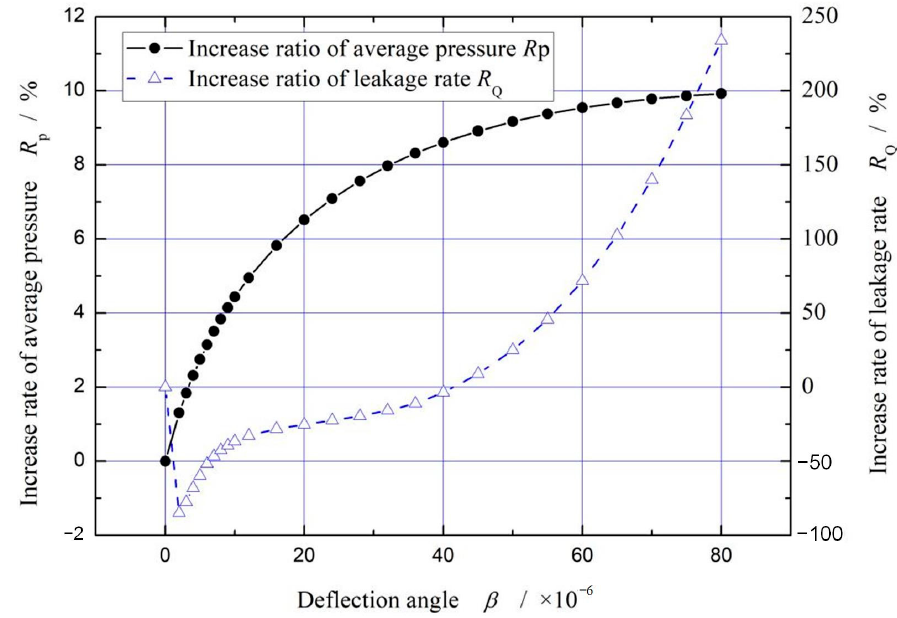
Figure 5. Influence of deflection angle on dimensionless mean pressure and leakage. ( p i = 0.2 MPa, ω = 3.0 × 10 4 r/min, T in = 580 K, T out = 380 K, p s = 0.03 MPa).